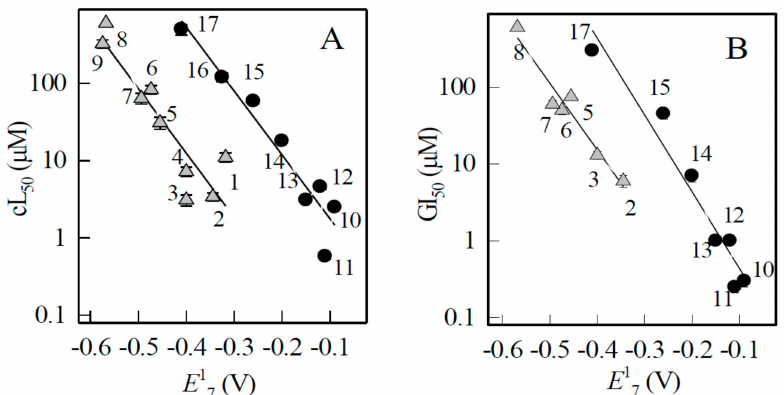
Figure 4. Dependence of cytotoxicity and growth inhibition potency of ArN → O and quinones on their single-electron reduction midpoint potential. ( A ) Cytotoxicity of ArN → O (triangles) and quinones (circles) in MH22a cells. ( B ) Growth inhibition potency of ArN → O (triangles) and quinones (circles) HCT-116 cells. The numbers of compounds correspond to those in Table 1. The cytotoxicity and growth inhibition potency of ArN → 0 and quinones is described by the first order polynomial regressions.